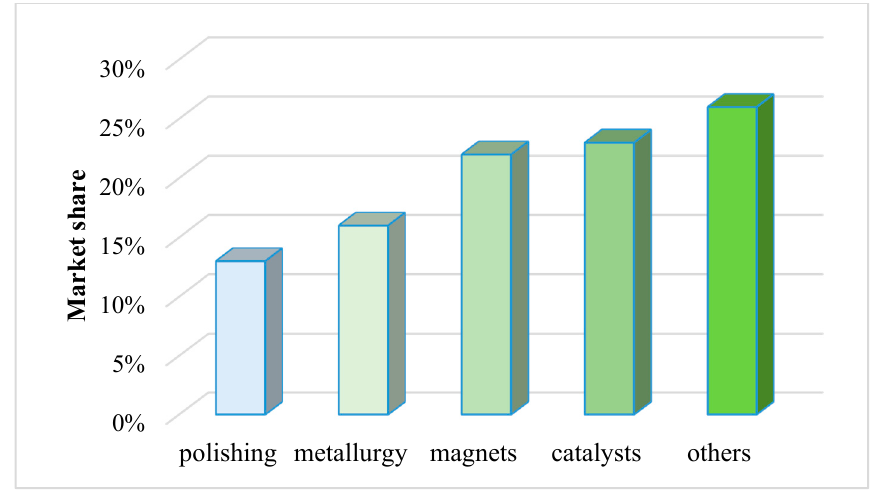
Figure 2. Market share of global consumption of rare earth oxides (based on data from the United States Geological Survey (USGS) [39]).